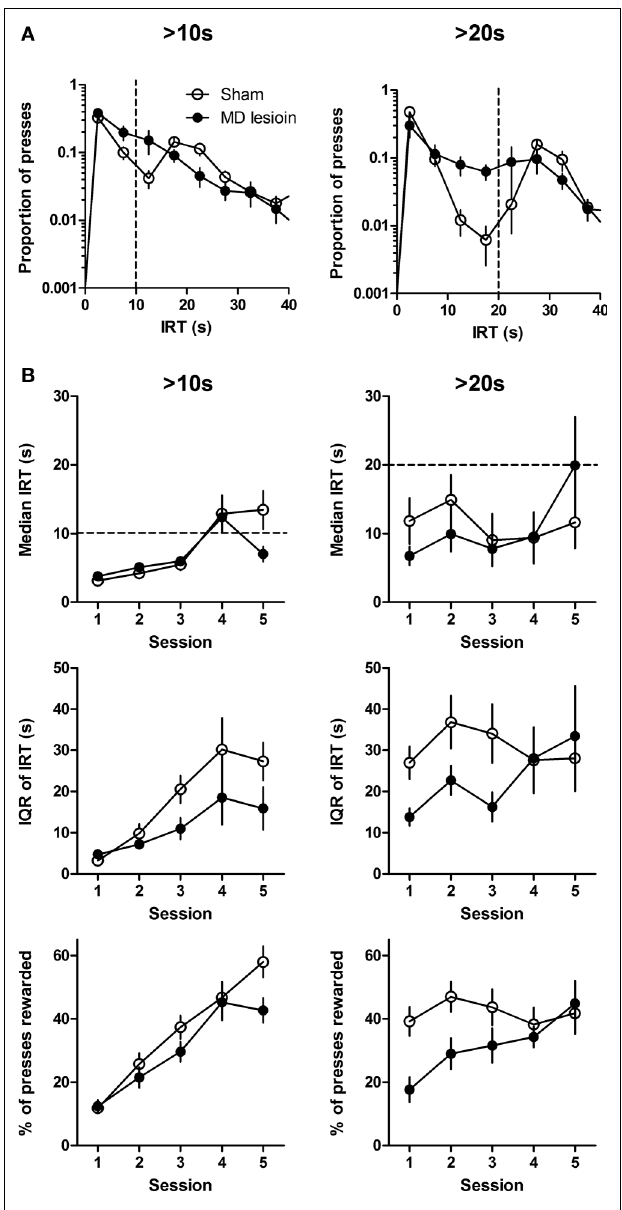
FIGURE 5 | Temporal differentiation of inter-response-time (IRT). (A) The distribution of IRTs during the last session for each criterion IRT. Dashed line indicates criterion IRT. (B) Response dynamics of median IRT, interquartile range of IRT, and proportion of presses rewarded across fi ve sessions at each criterion IRTs. Error bar represents SEM.